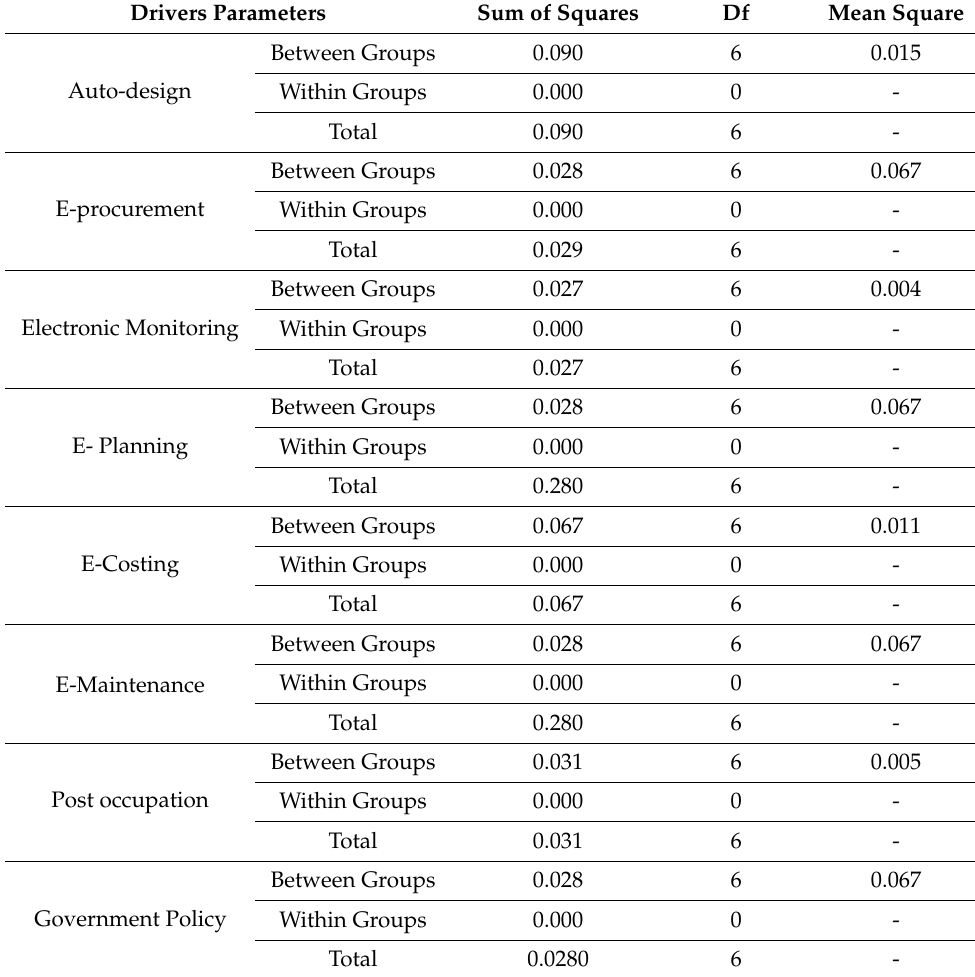
Table 4. Analysis of Variance Table (ANOVA) on Industrial Application Drivers of I4.0 and C4.0 is critical in Achieving C4.0.